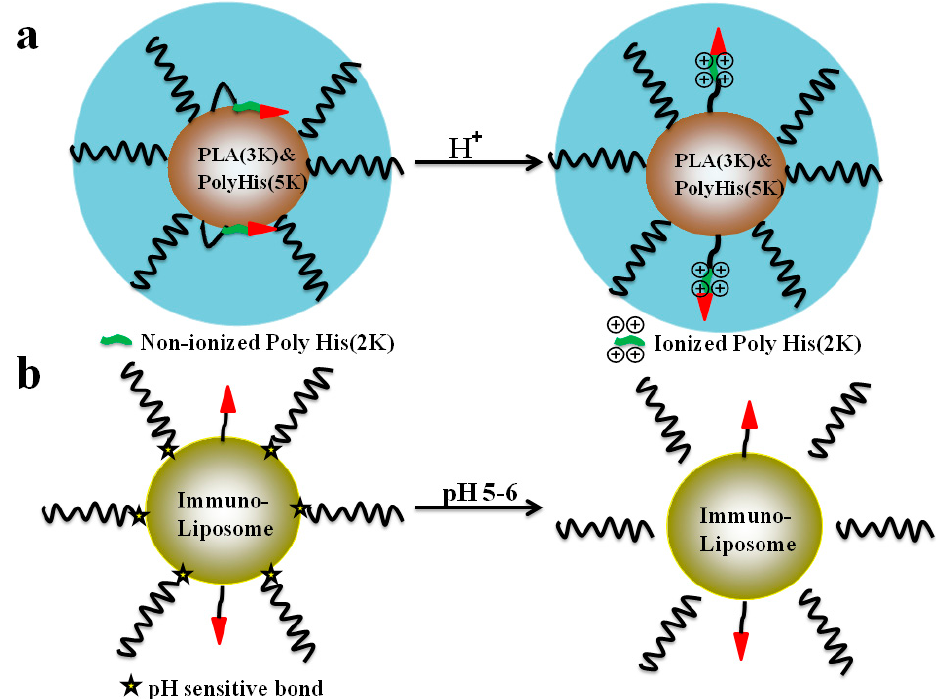
Figure 4. Examples of the pH-sensitive nano-carriers equipped with an efficient CPP exposure: ( a ) polyHis-based micelles responded to acidic tumor microenvironments by an efficient CPP exposure; and ( b ) TAT-peptide-decorated liposomes comprising a hydrolyzable PEG shell allowing improved exposure of the TAT (redrawn according to [105,106]).